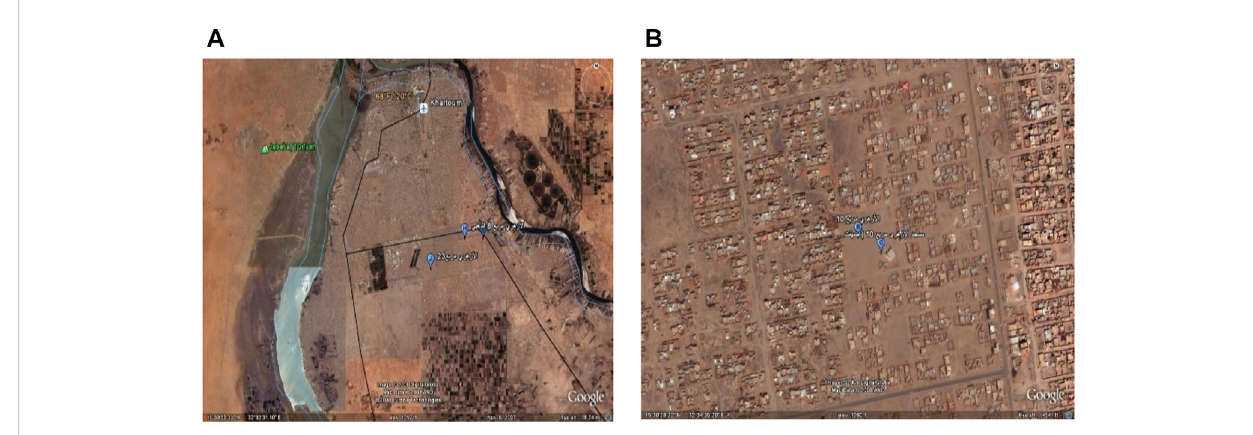
FIGURE 1 Satellite view of Al-Azhari City (suburban area of Khartoum). (A) Location of Al-Azhari City, Khartoum State. (B) Area of Azhari City Block